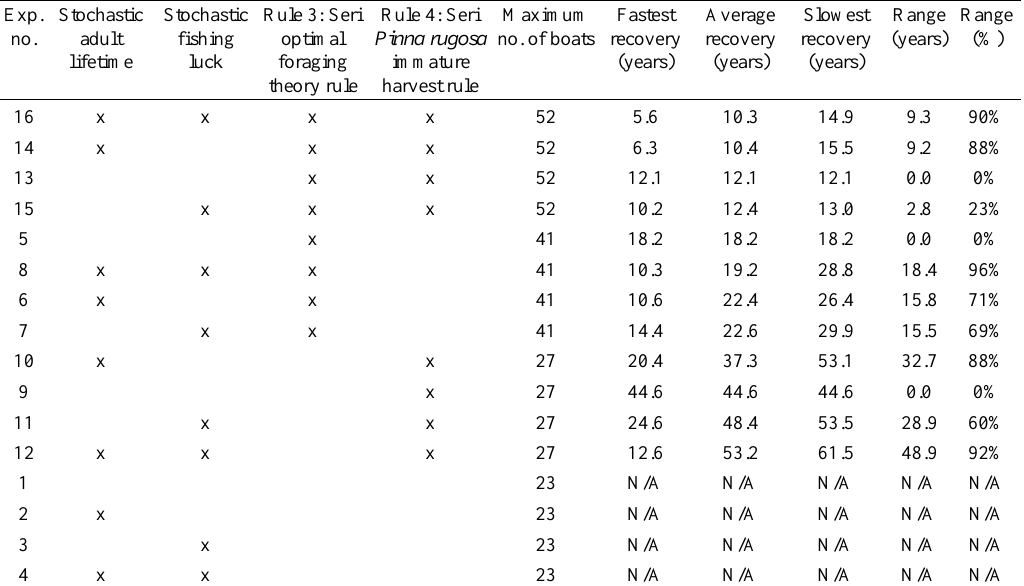
Table 2. Recovery experiments, sorted by average recovery period. The letter x indicates which stochastic variables and/or institutional rules are active in each experiment. Range is the difference between the fastest and slowest recovery